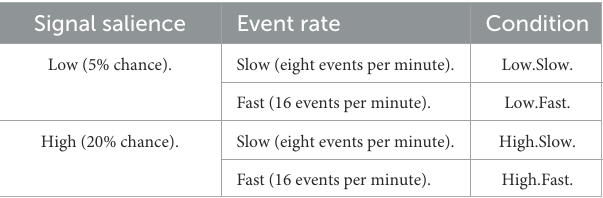
TABLE 2 Levels of event rate and signal salience examined by Sawyer et al. (2016). Signal salience